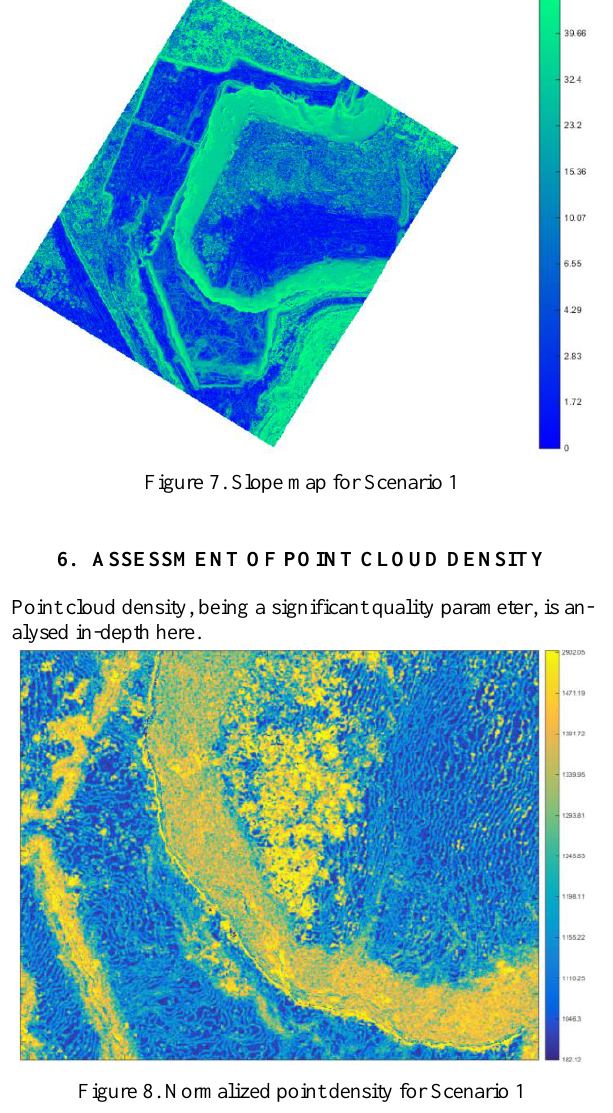
Figure 9. The bushes located at the lower flat part of the site